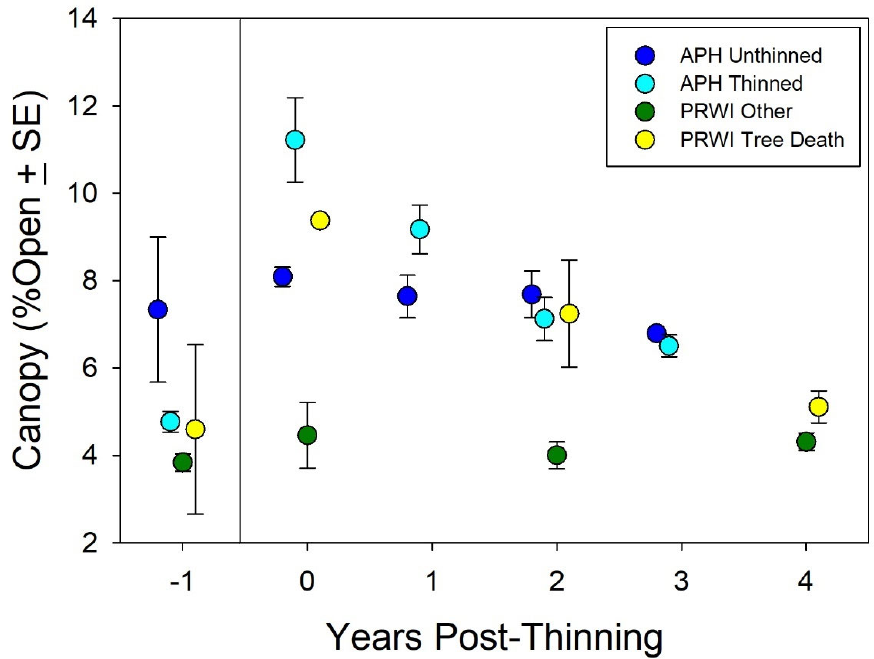
Figure 2. Graph of mean canopy openness (± standard error across multiple colonies and multiple image locations in each colony) at Isotria population locations before and after canopy thinning (APH) and the death of a canopy tree (PRWI). ‘PRWI Other’ refers to populations at PRWI where no canopy tree died.